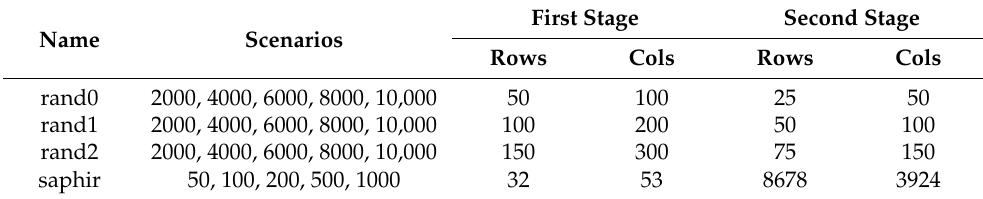
Table A7. Sizes of SLP instances